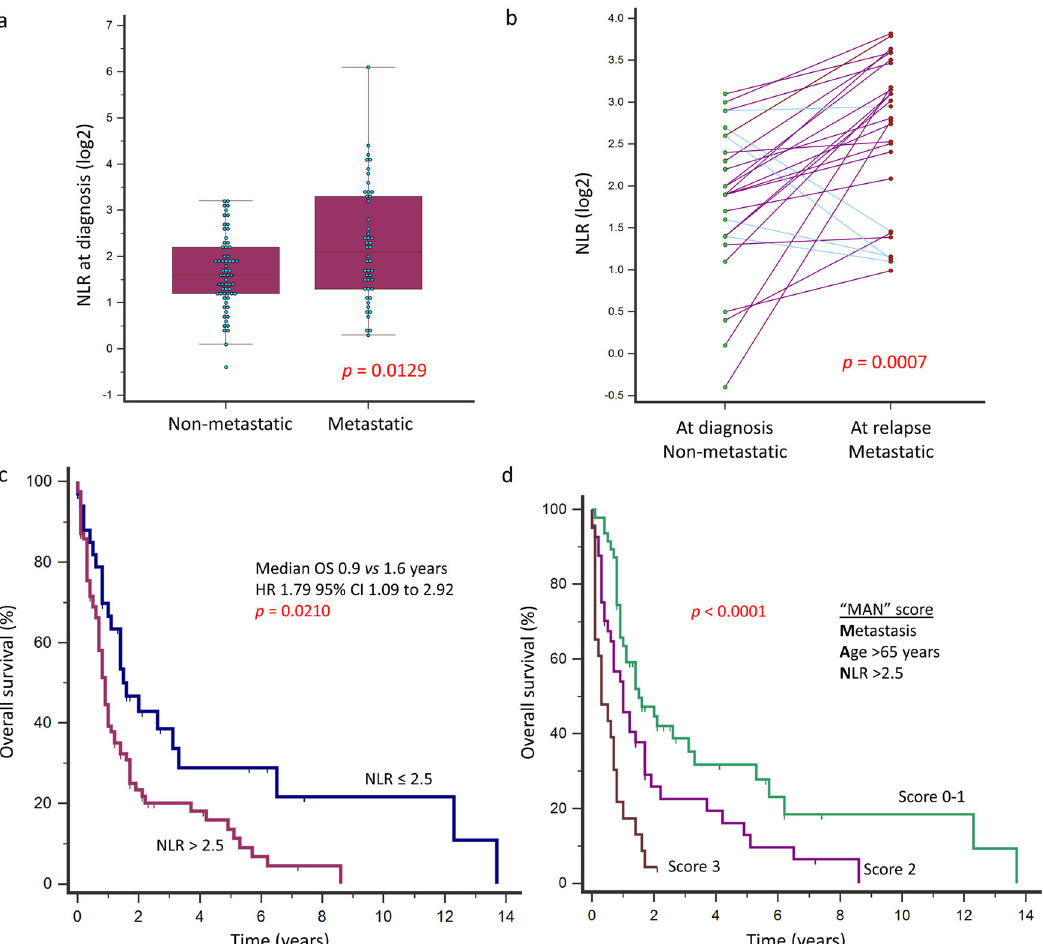
Fig. 4 Peripheral blood NLR and survival outcomes in angiosarcoma. a Patients with distant metastasis at diagnosis had higher NLR ( p = 0.0129, Mann-Whitney U test) (Boxplot elements: center line, median; bounds of box, lower and upper quartiles; whiskers, minimum and maximum values.). b Progression of localized disease at diagnosis to metastatic relapse within the same patients was associated with an increase in NLR ( p = 0.0007, Wilcoxon signed-rank test). c High NLR > 2.5 was independently associated with worse OS. d Patients were